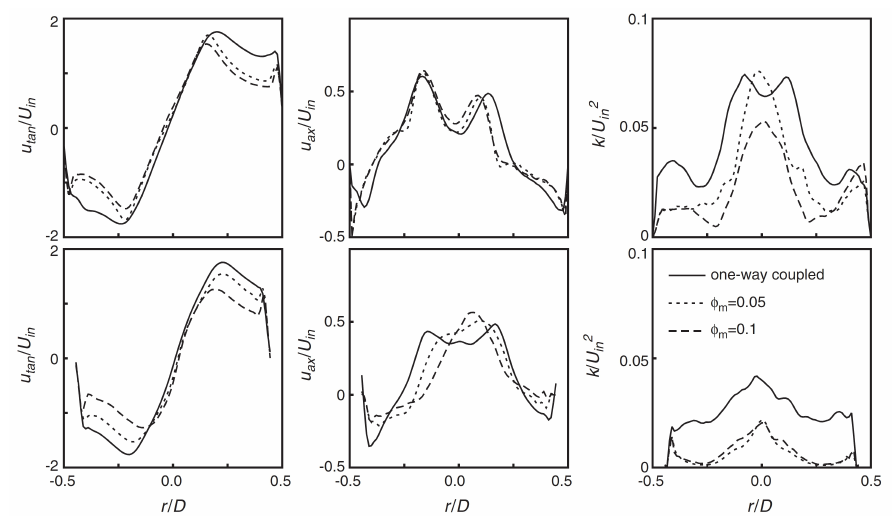
Figure 6. The predicted time-averaged values of axial and tangential velocities as well as the resolved turbulent kinetic energy of the gas for a pilot-scale cyclone with a body diameter of 0.29 m and operating with different mass loadings of particles using two-way coupled LES at 0.75D (top) and 2D (bottom) below the cyclone roof [116]. Reproduced with permission from J.J. Derksen, Simulation of mass-loading effects in gas-solid cyclone separators; published by Elsevier,